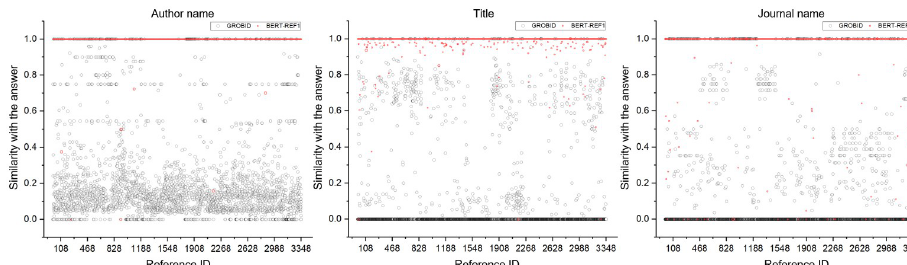
Fig 9. Visualization of the similarity values and differences between BERT-REF1 and GROBID for the three metadata field types in the 3,348 non-English references. The X-axis represents each non-English reference. The red circles indicate the similarity values for the non-English references for BERT-REF1, and the black circles represent the corresponding similarity values for GROBID.